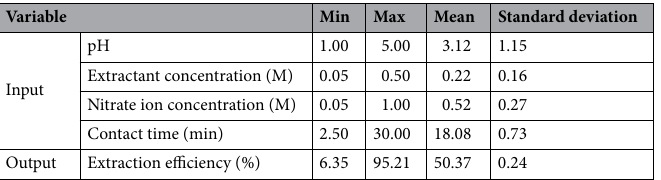
Table 2. Range of studied variables and the statistics summary (number of observations was 39).